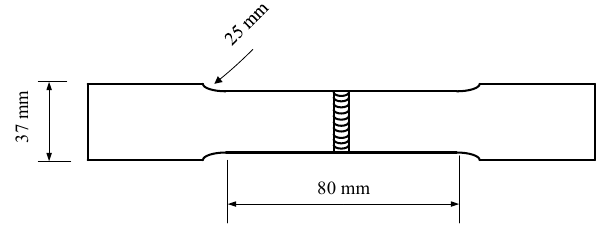
Figure 6. Schematic diagram of the tensile specimen size.